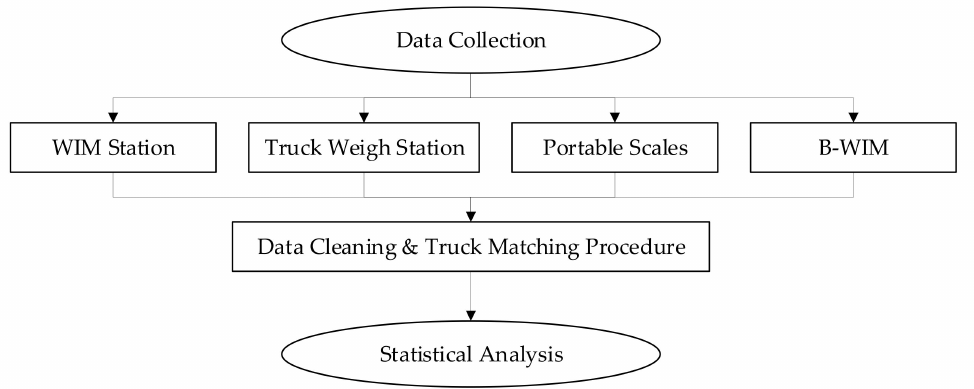
Figure 6. Traffic data collection flowchart.